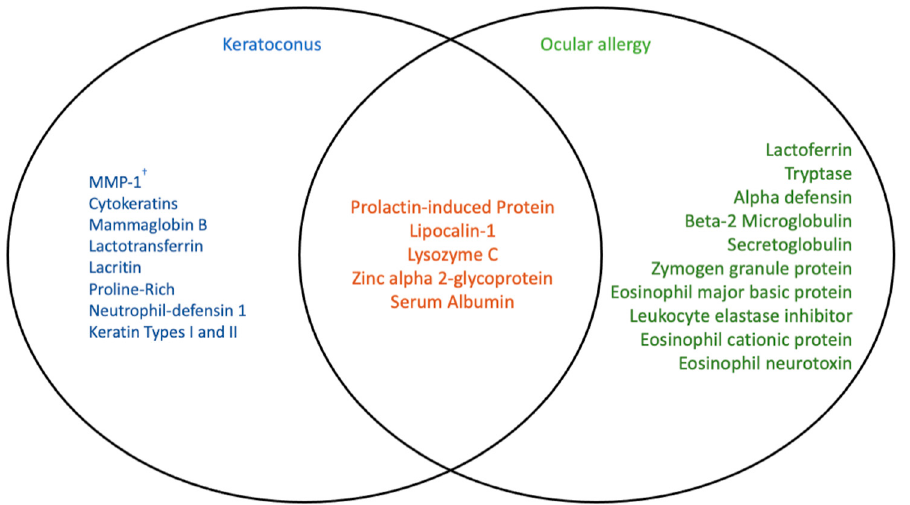
Figure 3. Comparison of differentially expressed proteins in patients with keratoconus and ocular allergy, and proteins that are altered in either condition [3,21,40,47,48,50–57]. Ocular allergy and keratoconus have been linked in recent research through ocular surface changes caused by increased eye-rubbing experienced by sufferers of both conditions. Protein expression on the ocular surface in both conditions has been studied recently, as overlapping key proteins appear to be affected similarly. † MMP—matrix metalloproteinase .